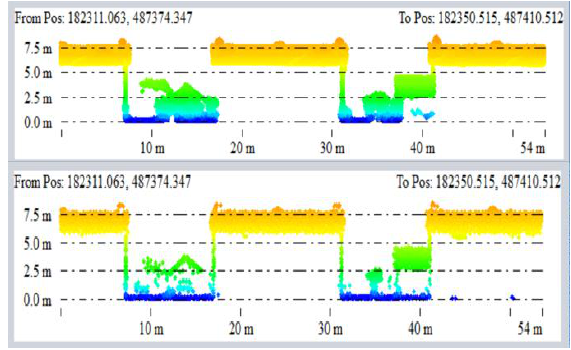
Figure 11. UAV (top) and ALS (Bottom)point cloud